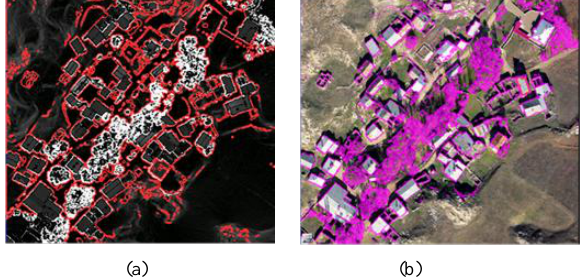
multi-resolution segmentation (b)